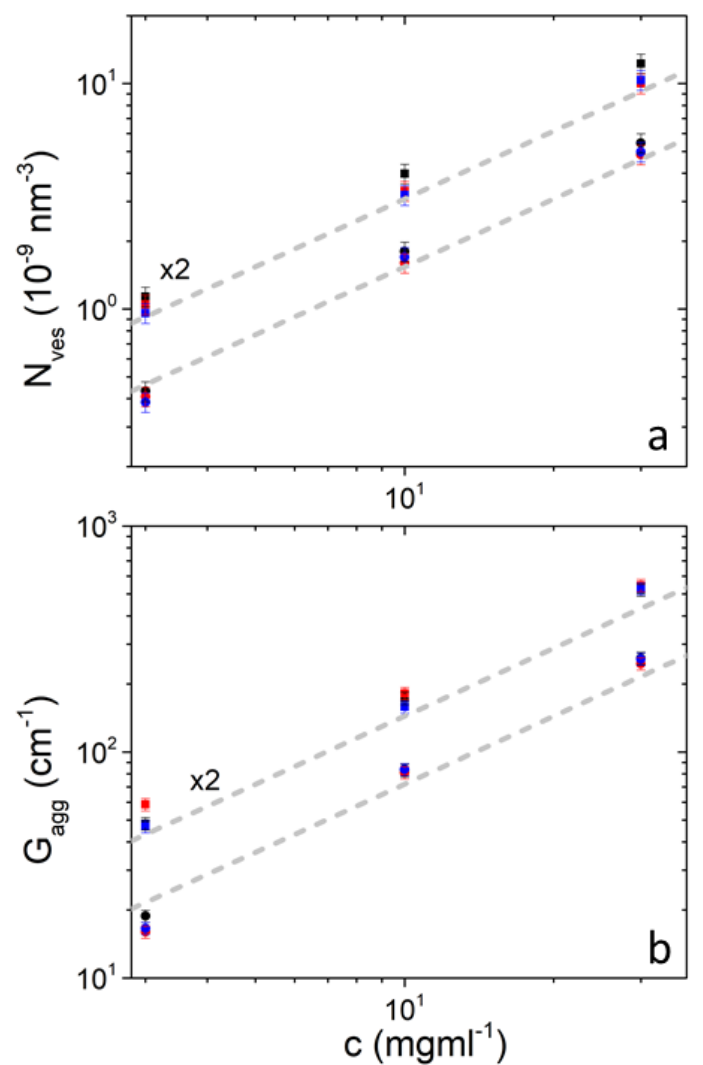
Figure 2. Number of vesicles per unit volume ( a ) and aggregates’ forward scattering ( b ) in solutions of DPPC/PEO-b-PCL1 (circles) and DPPC/PEO-b-PCL2 (squares) at 25 ◦ C (black), 37 ◦ C (red) and 45 ◦ C (blue). Data from DPPC/PEO-b-PCL2 are multiplied by 2 for clarity. Gray dashed lines have slope equal to 1 and differ by a factor of 2.